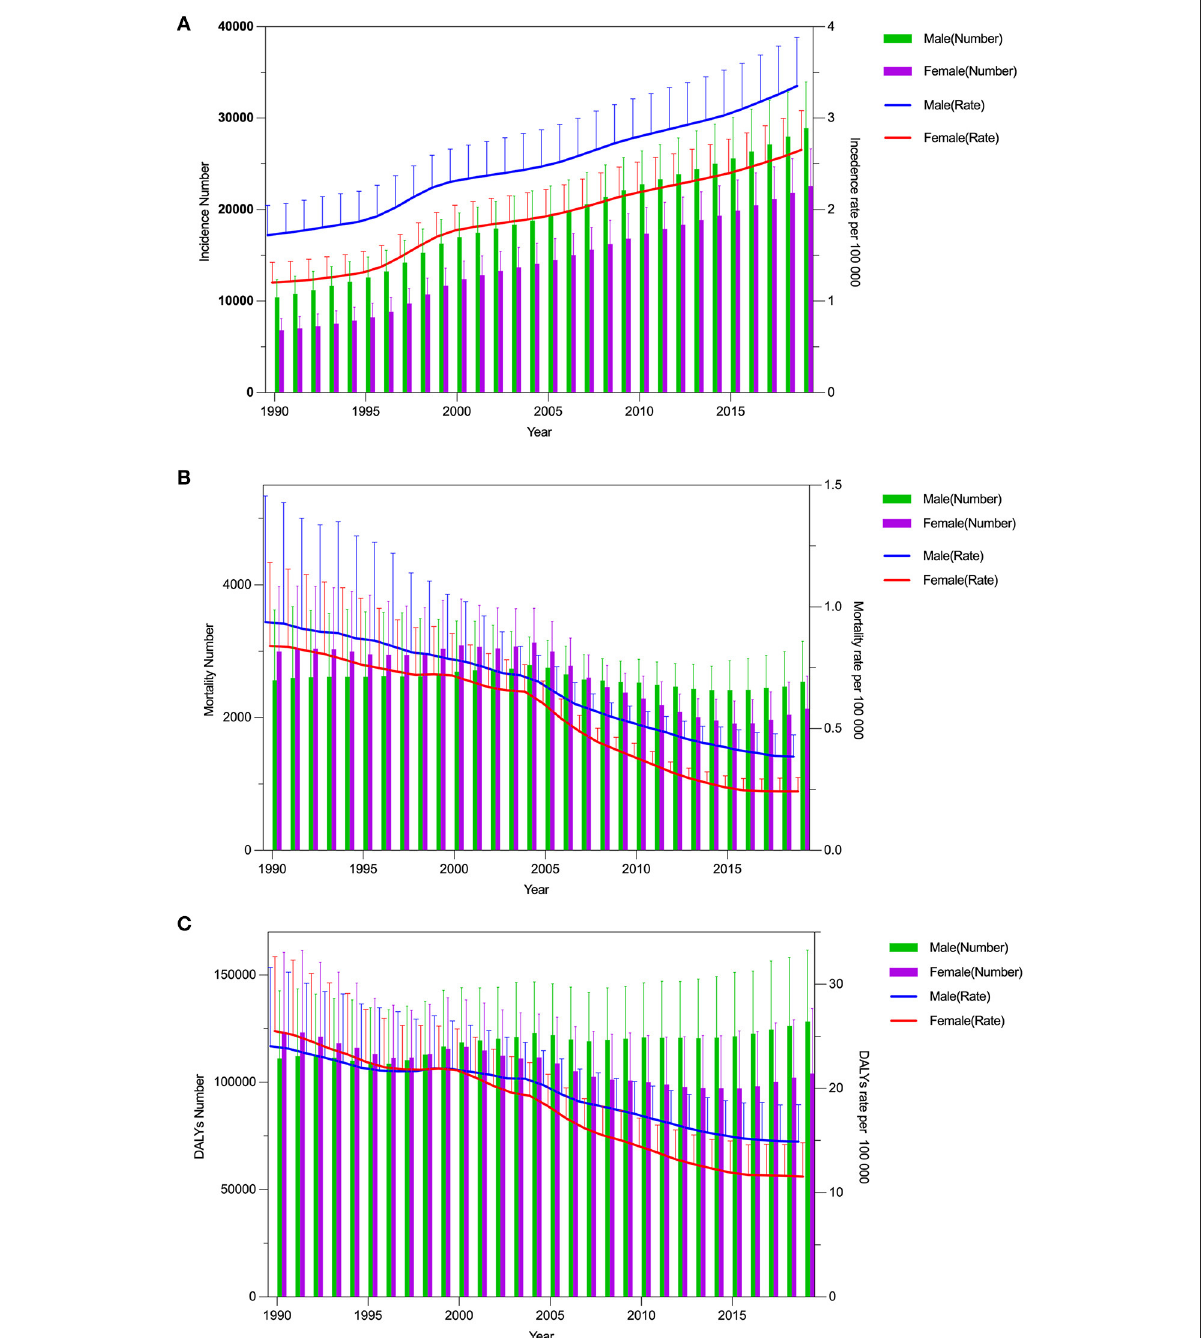
FIGURE2 Trends in the all-age cases and age-standardized incidence, mortality, and DALYs rates of IBD by sex from 1990 to 2019. (A) Incidence number and rate. (B) Mortality number and rate. (C) DALYs number and rate.